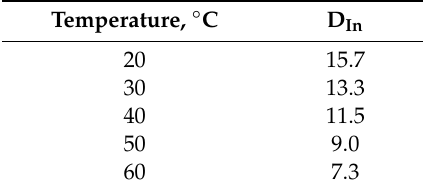
Table 1. Variation of indium extraction with